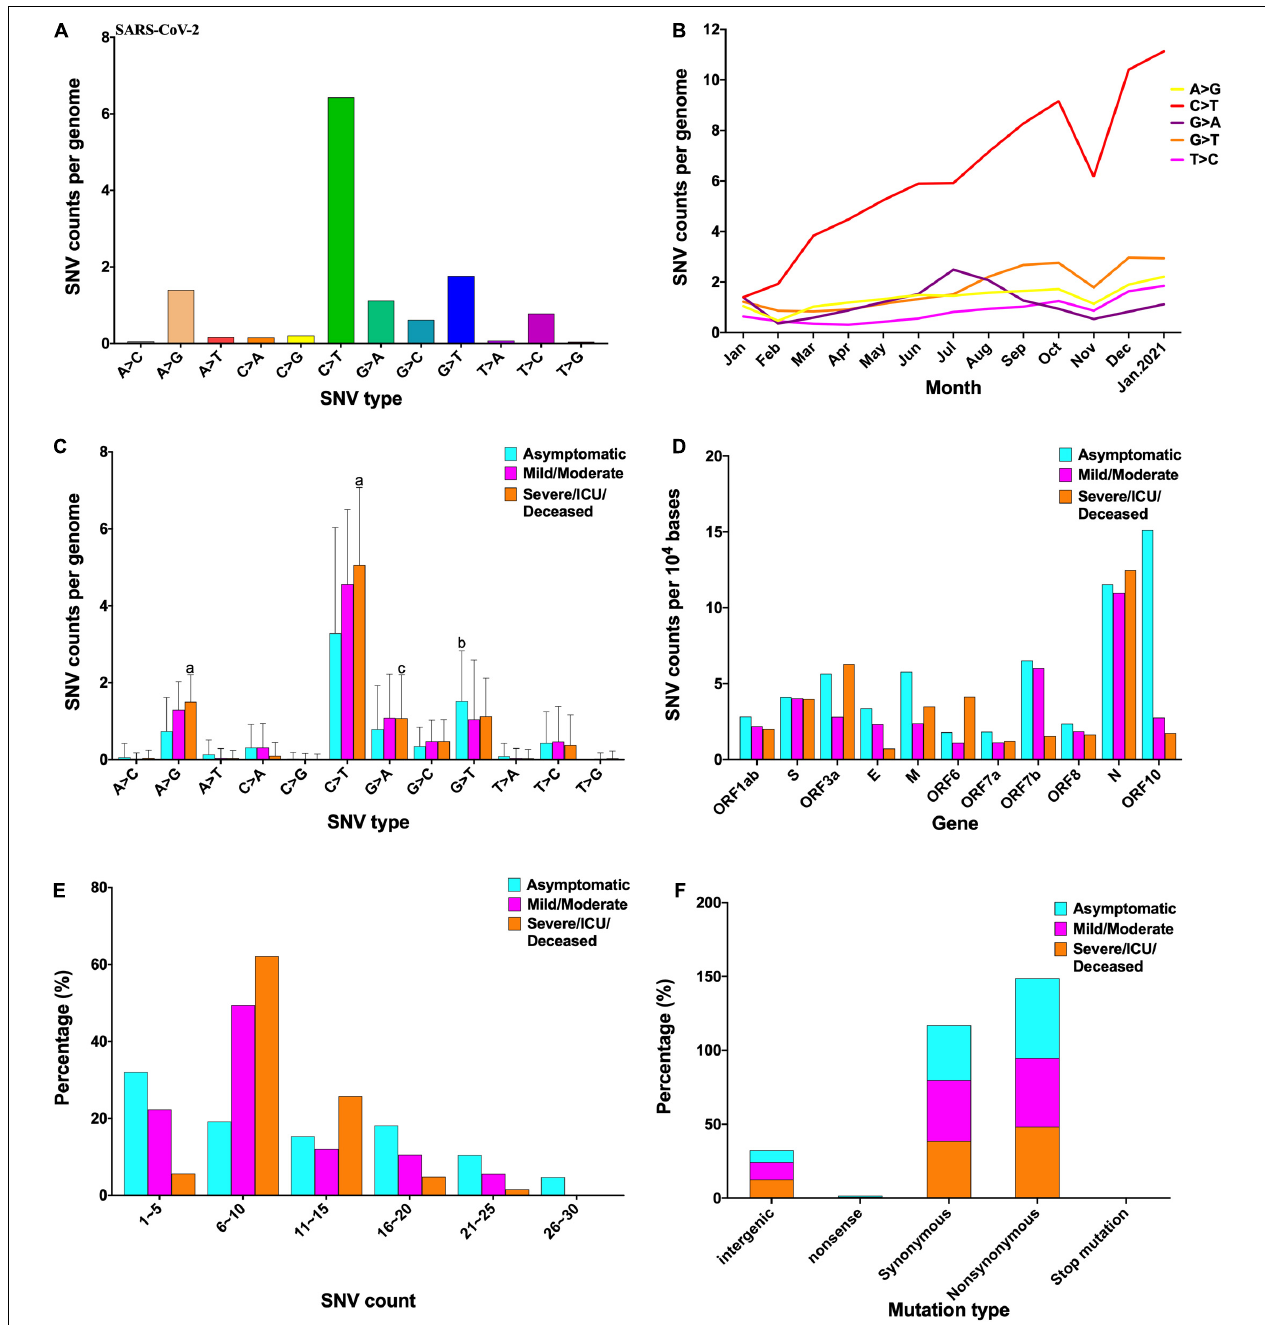
FIGURE 1 | Characterization of mutations in the SARS-CoV-2 genome. (A) SNV type in the SARS-CoV-2 genome. (B) Dynamics of SNV counts over time. (C) Number of different SNV types distributed in the three clinical outcomes. (D) SNVs of three clinical outcomes distributed in the gene of SARS-CoV-2. (E) Ranges of SNV counts in the three clinical outcomes. (F) Mutation results of three clinical outcomes. a p < 0.001, b p < 0.01, and c p < 0.05 represent that there is significant difference among the three clinical outcomes. All results were analyzed using one-way ANOVA followed by the Student–Newman–Keuls test. SARS-CoV-2, severe acute respiratory syndrome coronavirus 2; SNV, single-nucleotide